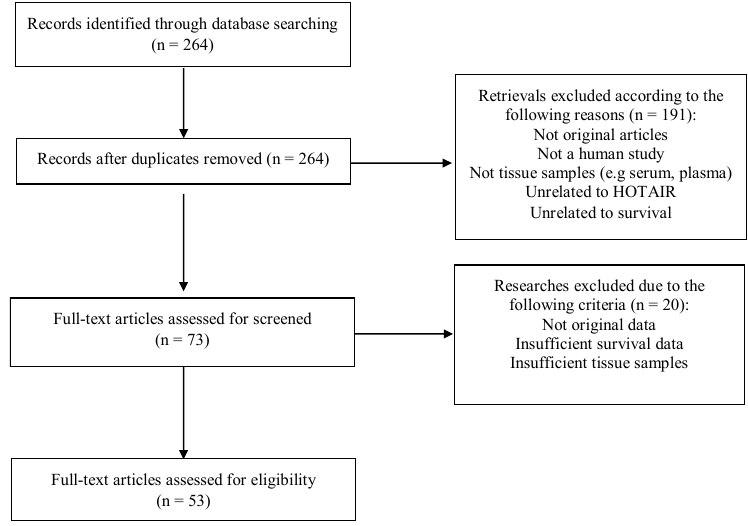
Figure 1. Flow chart of the process for study selection.